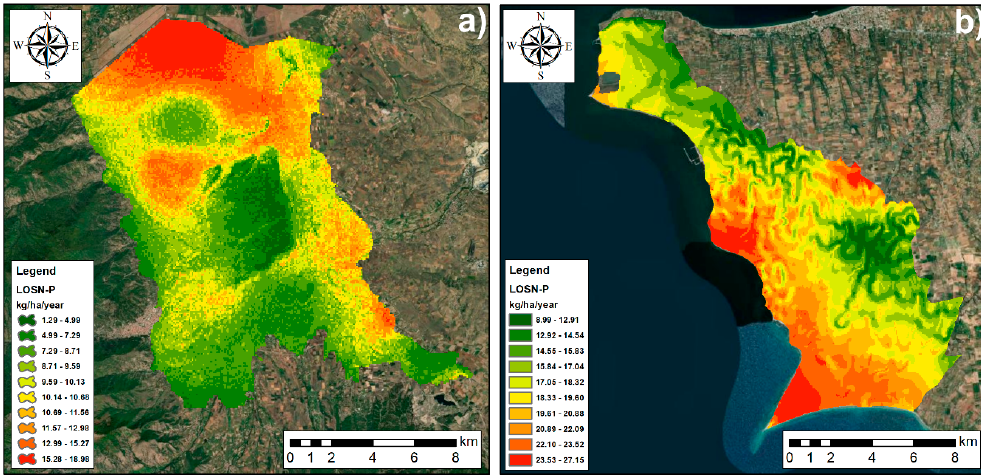
Figure 3 . LOSN-P application for a) the Florina basin, and b) the Epanomi coastal area. 221 Figure 3. LOSN-P application for ( a ) the Florina basin, and ( b ) the Epanomi coastal